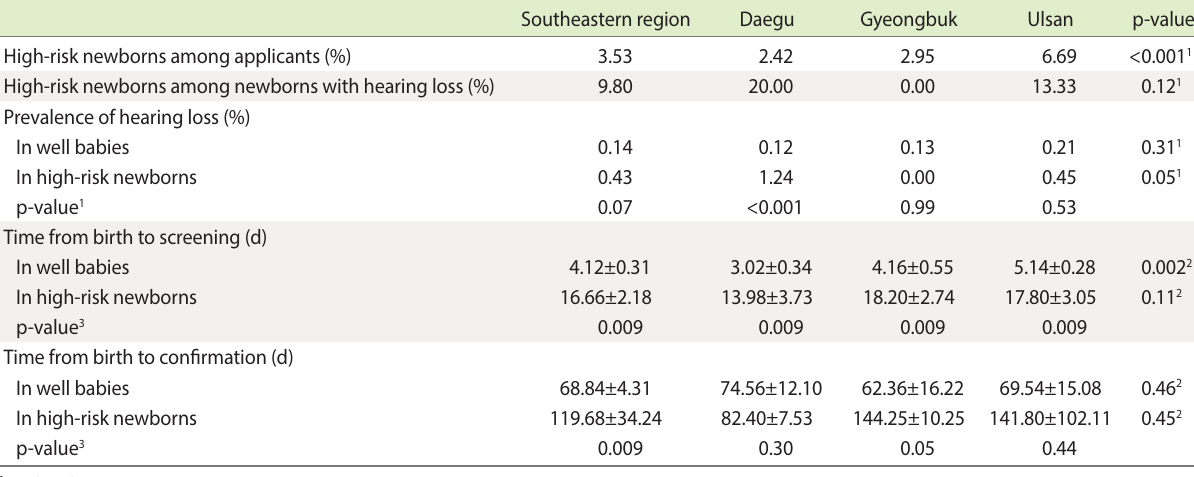
Table 3. Data of newborn hearing screening in well babies versus newborns with high-risk factors of hearing loss (2011-2015)